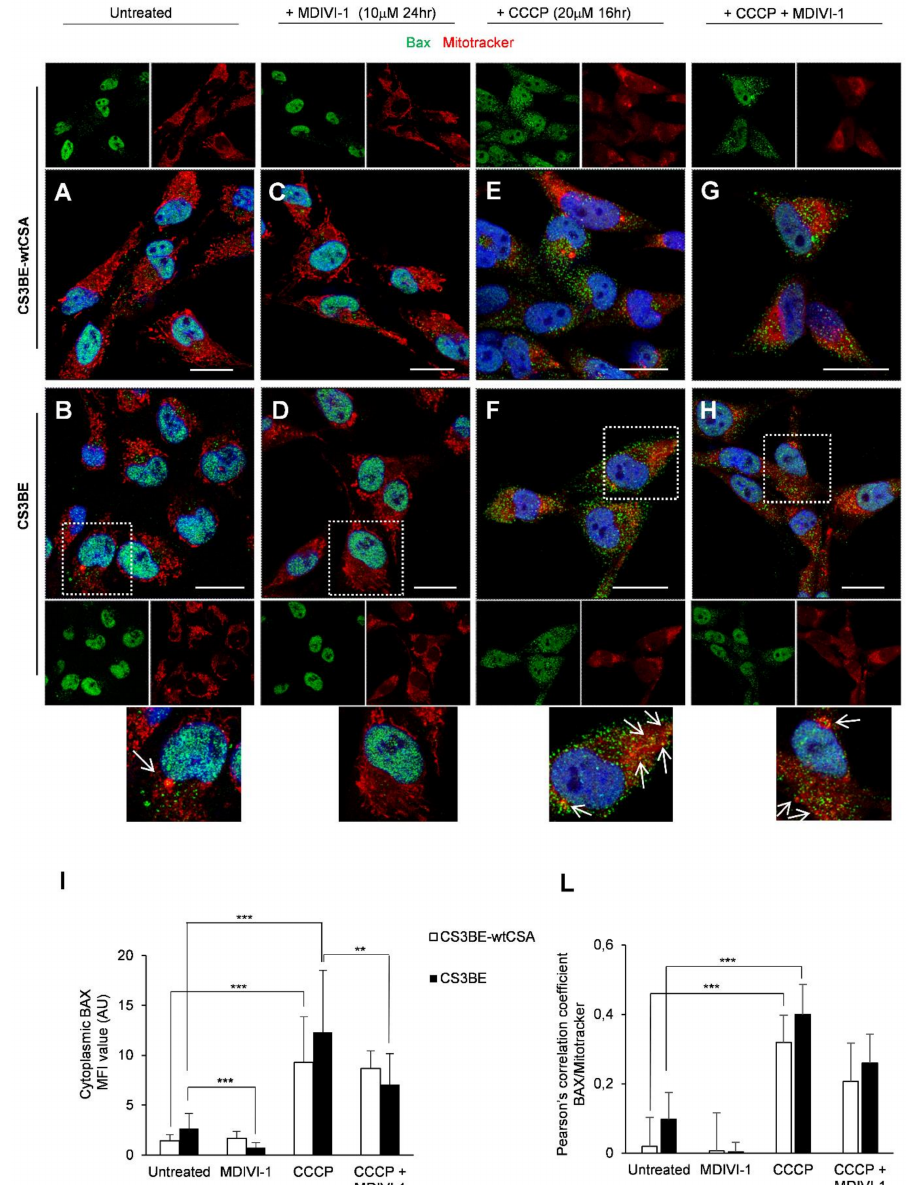
Figure 5. MDIVI-1 treatment decreases the level of apoptotic Bax at mitochondria. ( A – H ) Detection of Bax and mitochondria by CLSM examinations in CS3BE-wtCSA and CS3BE cells. ( A , B ) untreated; ( C , D ) MDIVI-1 (10 µ M for 24 h); ( E , F ) CCCP (20 µ M for 16 h); ( G , H ) MDVI-1 and CCCP treated. Living cells were stained with Mitotracker ® Deep Red FM (detected in red), fixed, permeabilized and labelled with polyclonal anti-Bax Ab (green). Nuclei are reported in blue (DAPI). Colocalization areas (detected in yellow) are shown in merged images. Insets represent separate channel images. For CS3BE cells a higher-power magnification image of a selected cell for each experimental condition is shown, with arrows indicating Bax-positive mitochondria. Scale bars, 20 µ m. Panels are representative of three independent experiments. ( I ). Mean fluorescence value of cytoplasmic Bax in each experimental condition. ( L ). Quantification of colocalization of Bax with mitochondria after treatment with MDIVI-1 and/or CCCP, as determined by Pearson’s correlation coefficient measured in all microscopy images (mean ± SD). *** p < 0.0001, ** p < 0.01 by Mann–Whitney